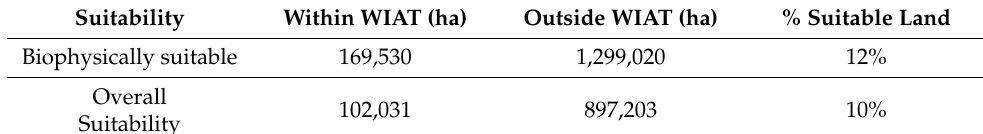
Table 11. Area of suitable land that is within and outside WIAT 1 km buffer.